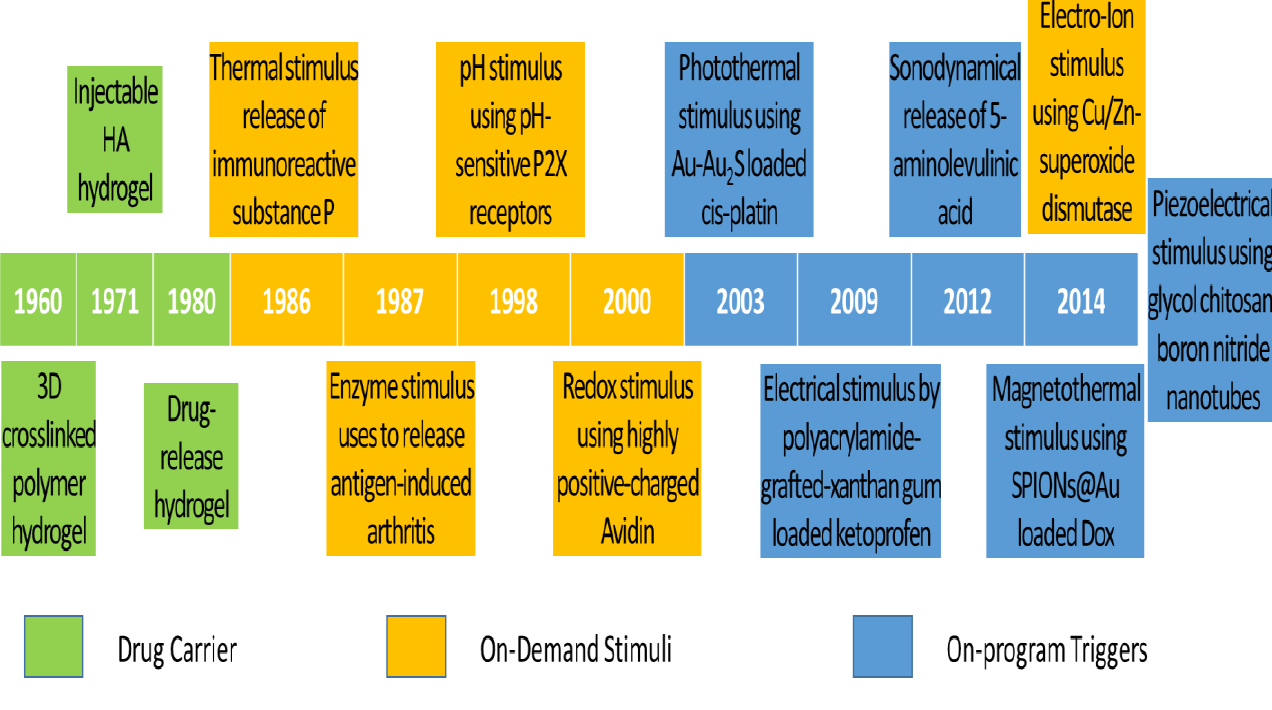
Figure 1. Timeline of significant discoveries and advancements in drug delivery systems with drug carriers, on-demand stimuli, and on-program triggers.